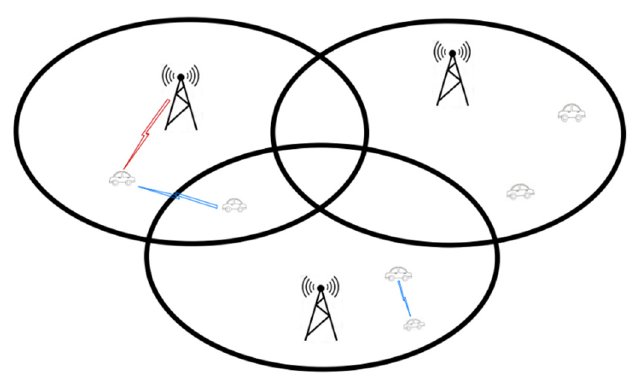
Figure 2. Vehicular network collaboration model.